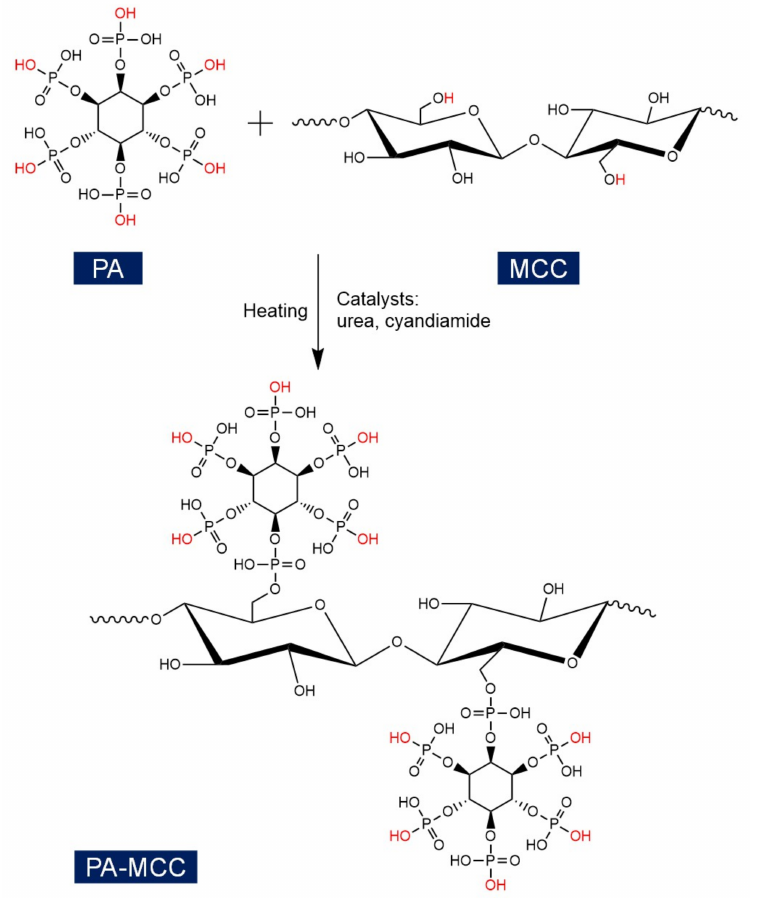
Figure 1. Schematic diagram of the preparation of PA modified